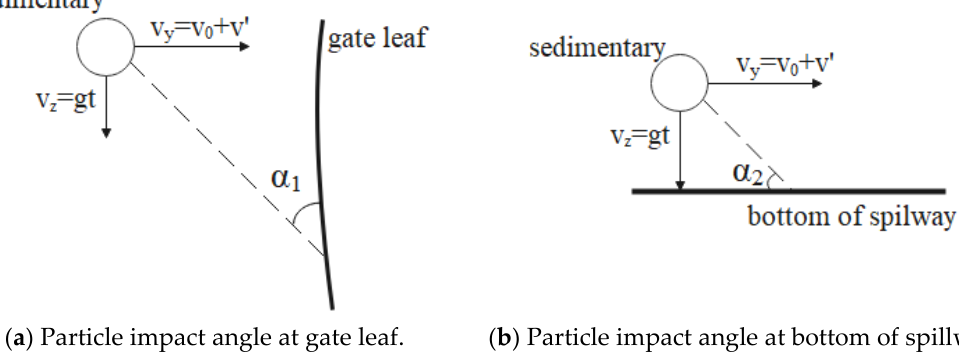
Figure 13. Velocity component of particle impact.